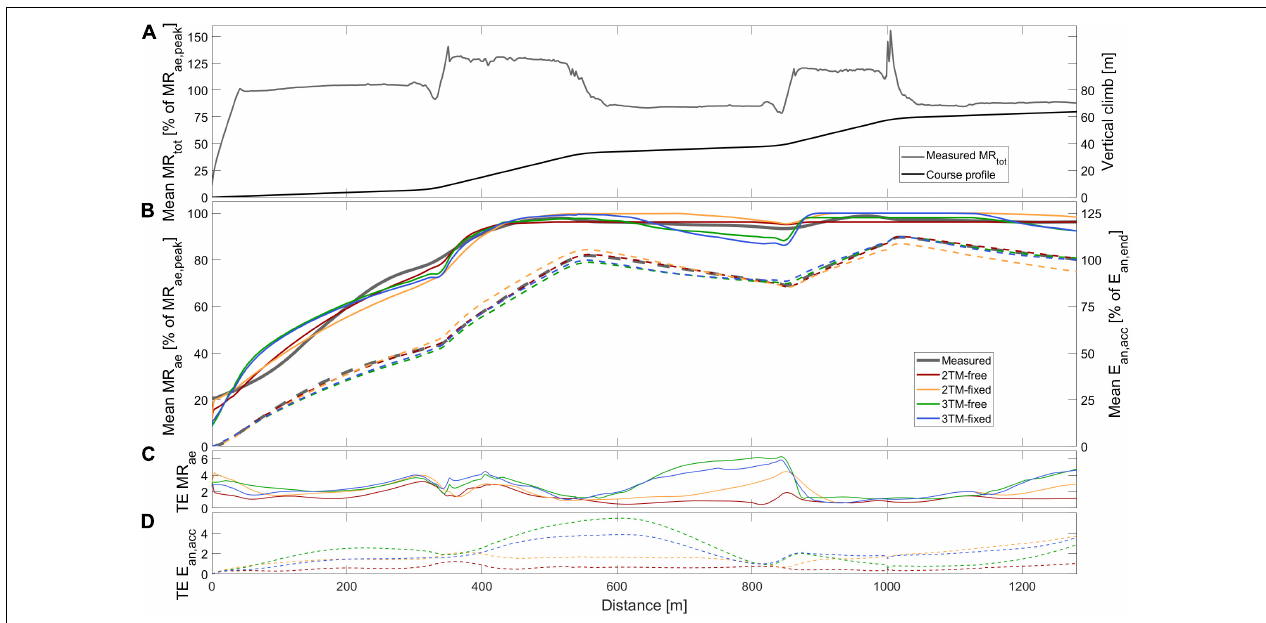
FIGURE 1 | Measured and modeled metabolic variables during STT1 including (A) group mean of total metabolic rate (MR tot ), course profile, (B) mean aerobic metabolic rate (MR ae , solid), accumulated anaerobic energy expenditure (E an , acc , dashed), (C) typical error of aerobic metabolic rate (TE MR ae ), and (D) typical error of anaerobic accumulated energy expenditure (TE E an , acc ). Metabolic rates are expressed relative to peak aerobic metabolic rate in STT1 (MR ae , peak ) and accumulated anaerobic energy expenditure is expressed relative to the accumulated anaerobic energy expenditure at the end of the course (E an , end ).